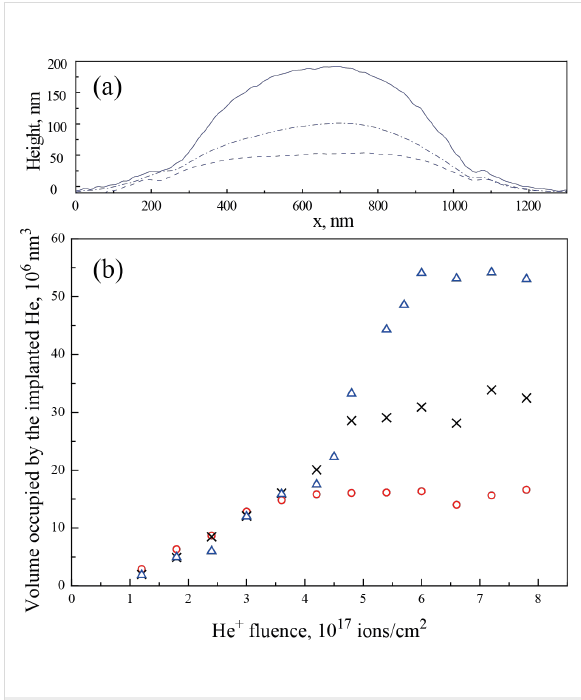
Figure 5: (a) Surface profiles after different ion fluences delivered by a 35 keV beam. The surface is evenly raised after 4.2 × 10 17 cm − 2 (dashed line). The dash-dotted line shows the profile of a blister that starts to form after a fluence of 4.8 × 10 17 cm − 2 . After 6 × 10 17 cm − 2 , the blister develops a stable shape (solid line). (b) Volume occupied by the implanted helium as a function of helium fluence. The beam prima- ry energies are 15 keV (red circles), 25 keV (black crosses) and 35 keV (blue triangles).